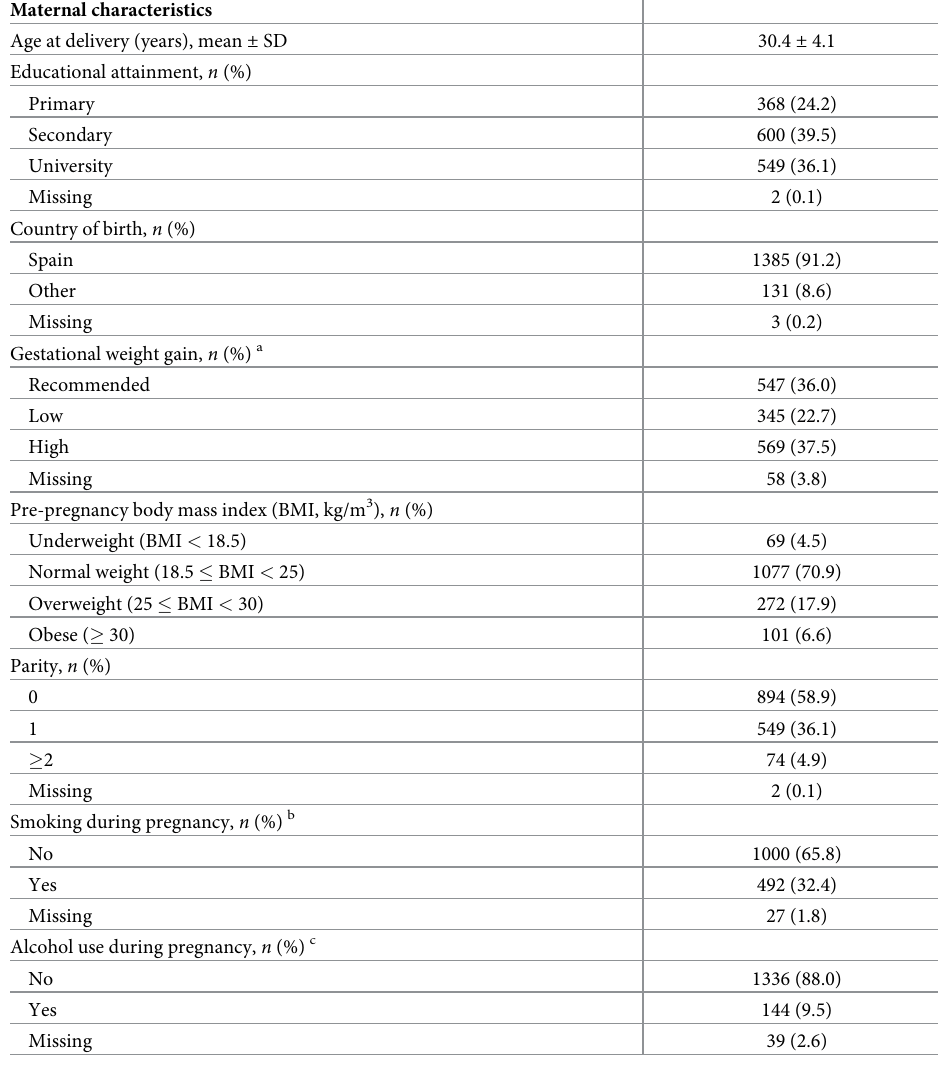
SD, standard deviation. a Gestational weight gain classified according to Institute of Medicine (IOM) guidelines [IOM/NCR (2009)]. b Self-reported maternal active smoking (yes/no) at 12 and/or 32 weeks of pregnancy.